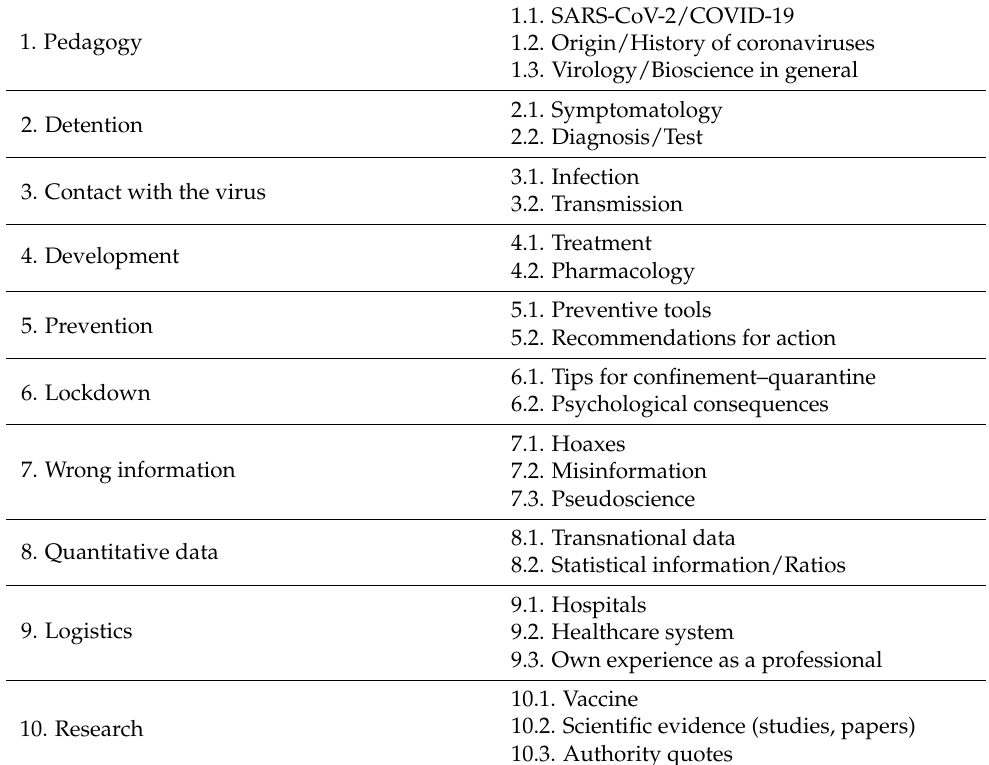
Table 3. Codebook for Thematic Taxonomy